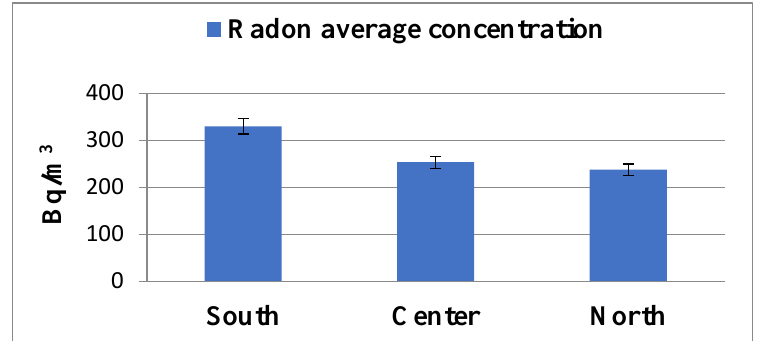
Figure 3. Variability of radon concentration in the Republic of Moldova depending on the area: South, Center and North; year 2019 ( n = 2435 total valid measurements with RADTRAK2 detectors, exposure period 90 days). The error bars indicate a 5% standard deviation of the data sets.